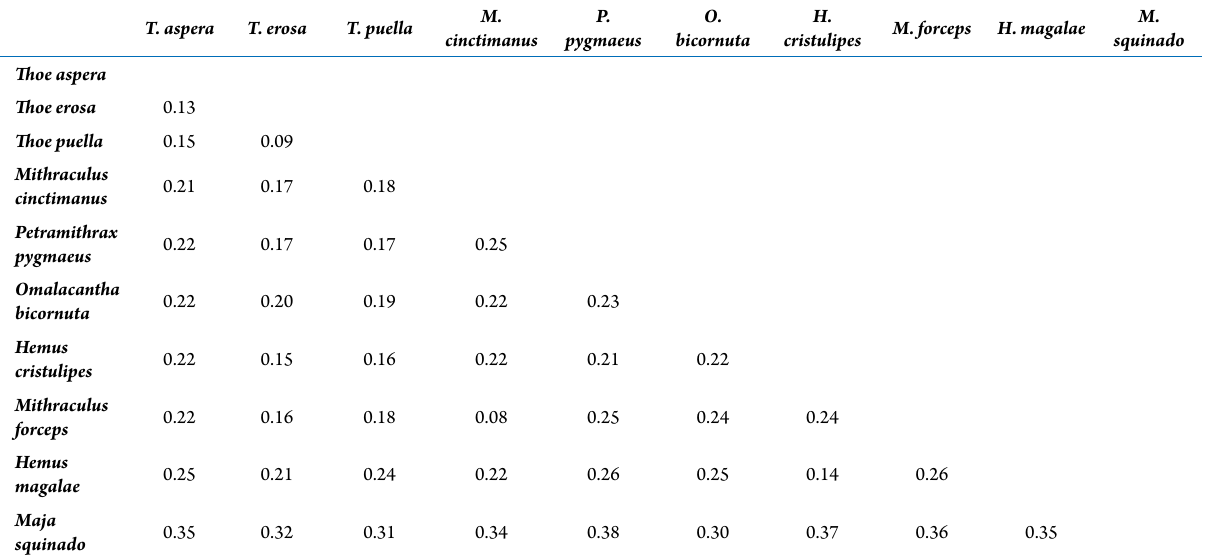
Table 2. Pairwise evolutionary divergence of partial 16 S rDNA sequences using Tamura-Nei model among Thoe and other Mithracidae species using Maja squinado as